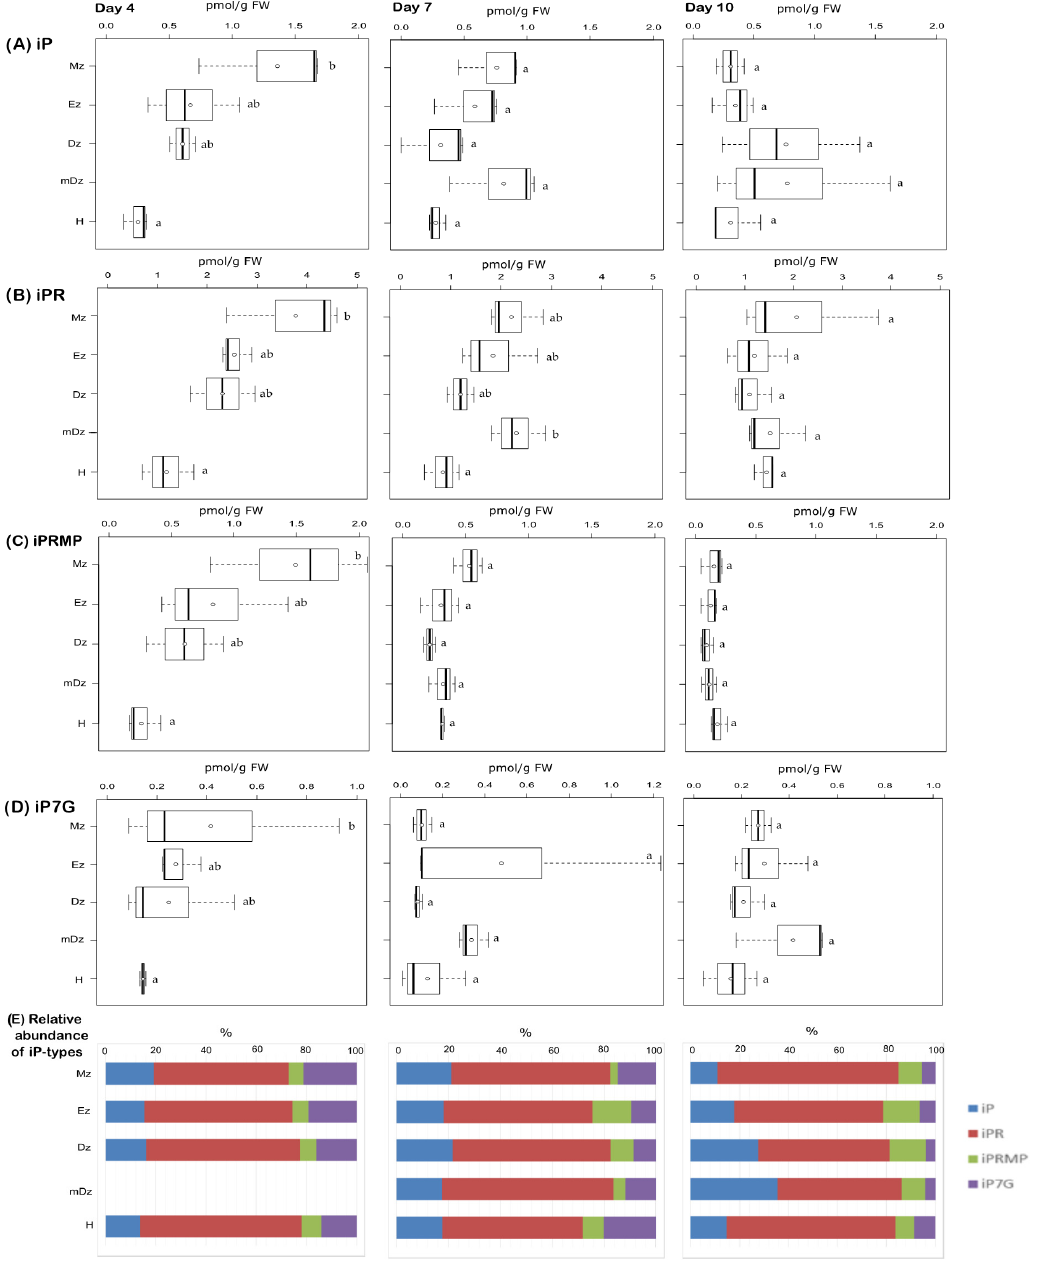
Figure 3. Quantification of iP-type cytokinins in hypocotyl and developmental root sections of cacao seedlings. Levels of ( A ) isopentenyladenine (iP), ( B ) isopentenyladenosine (iPR), ( C ) isopentenyladenosine-5 ′ -monophosphate (iPRMP), and ( D ) isopentenyladenine-7-glucoside (iP7G) were determined from the samples described in Figure 1. Isopentenyladenine- 9-glucoside (iP9G) levels were below the limit of detection in all samples. Dark vertical line indicates median; boxes rep- resent 25th and 75th percentiles; horizontal lines represent maximum and minimum values; circles indicate mean values. Significant variations in concentration determined by Welch’s test post hoc, p ≤ 0.05 among hypocotyl and primary root sections are indicated by letters, n = 3 independent biological replicates; FW = fresh weight. ( E ) Percent proportion of each iP-type cytokinin metabolite. At 4 DAI, levels of the free-base iP peaked at the Mz and decreased towards the H; this concentration gradient was not maintained in later stages (Figure 3A). The iP precursors iPR and iPRMP also showed a similar concentration gradient, especially at 4 DAI (Figure 3B,C). In hypocotyls, iP levels remained steady over the time points but usually lower than in roots (Figure 3A). Levels of the CK catabolite iP7G, which was the only CK N-glucoside